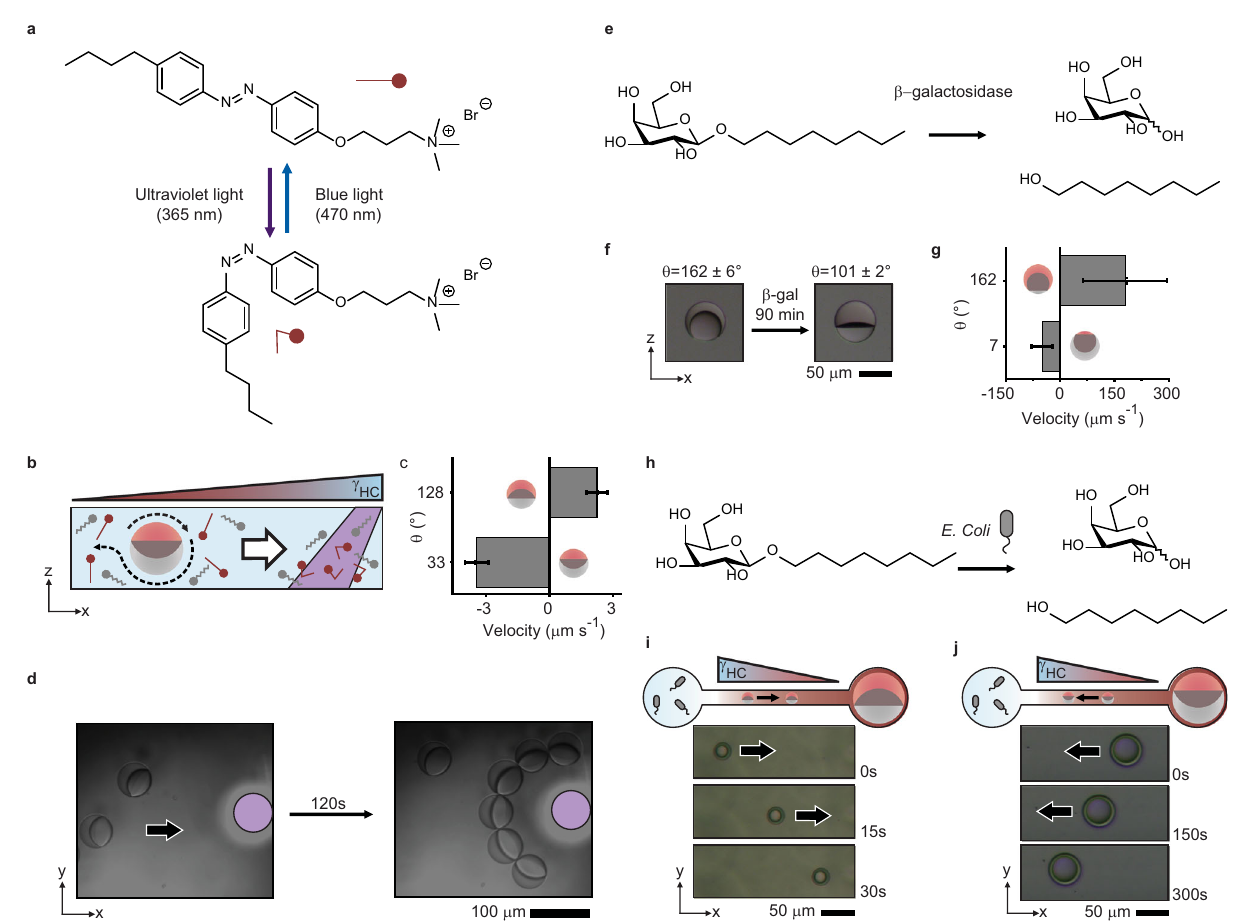
Fig. 5 Chemotaxis of Janus droplets in response to photo- and bio-chemically induced surfactant gradients. a Representation of the photo-triggered recon fi guration of an AzoTAB surfactant in response to the application of UV (365 nm) and blue (470 nm) light; b schematic sketch displaying the effect of local UV light application in the vicinity of AzoTAB stabilized Janus emulsions; c velocity of decane:methoxyper fl uorobutane droplets in AzoTAB:Zonyl versus the contact angle of the starting droplet, which respond to the gradient generated by AzoTAB and move away from the UV light spot dependent on starting morphology under blue irradiation, error bars denote > 5 measurements; d optical micrographs displaying a self-assembly of Janus droplets around a localized UV light spot (indicated) under bright fi eld blue light irradiation (Supplementary Movie 8); e chemical scheme for enzymatic ( β -galactosidase) cleavage of a galactose-based hydrocarbon surfactant; f decane:methoxyper fl uoroubutane droplets stabilized in 0.5 WT % β -n-octyl-galactopyranoside and 0.05 WT% Zonyl retain a hydrocarbon-dominant morphology ( θ = 162°). After the addition of 3U mL − 1 , the droplet morphology recon fi gures to θ = 101° as the hydrocarbon surfactant effectiveness is weakened by enzymatic cleavage of the hydrocarbon surfactant; g velocity of complex droplets composed of decane and methoxyper fl uorobutane in fl uorocarbon-dominant (0.5 WT% β -n-octyl-galactopyranoside, 0.1 WT% Zonyl, θ = 7°) and hydrocarbon-dominant (0.5 WT% β -n-octyl-galactopyranoside, 0.05 WT% Zonyl, θ = 162°) droplets to the addition of 10 µ L of their stabilizing mixture containing 3 U mL − 1 β -galactosidase, error bars denote > 5 measurements; h chemical scheme for an extracellular enzyme-mediated cleavage of the same surfactant upon addition of E.coli bacteria; i Janus droplets in a hydrocarbon-dominant morphology display chemotactic movement selectively away from the E. Coli colonies. j Due to the enzyme-mediated surfactant cleavage, Janus droplets in a fl uorocarbon-dominant morphology display chemotactic movement selectively towards the added E. Coli